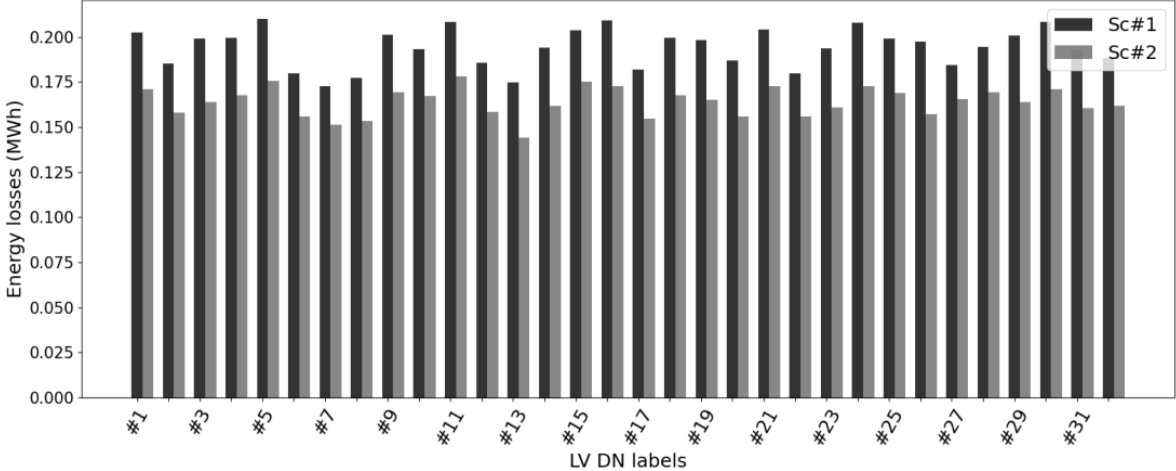
Figure 7. Power losses at each distribution system. Table 4. Results of average power loss reduction for the 32 LV DNs.